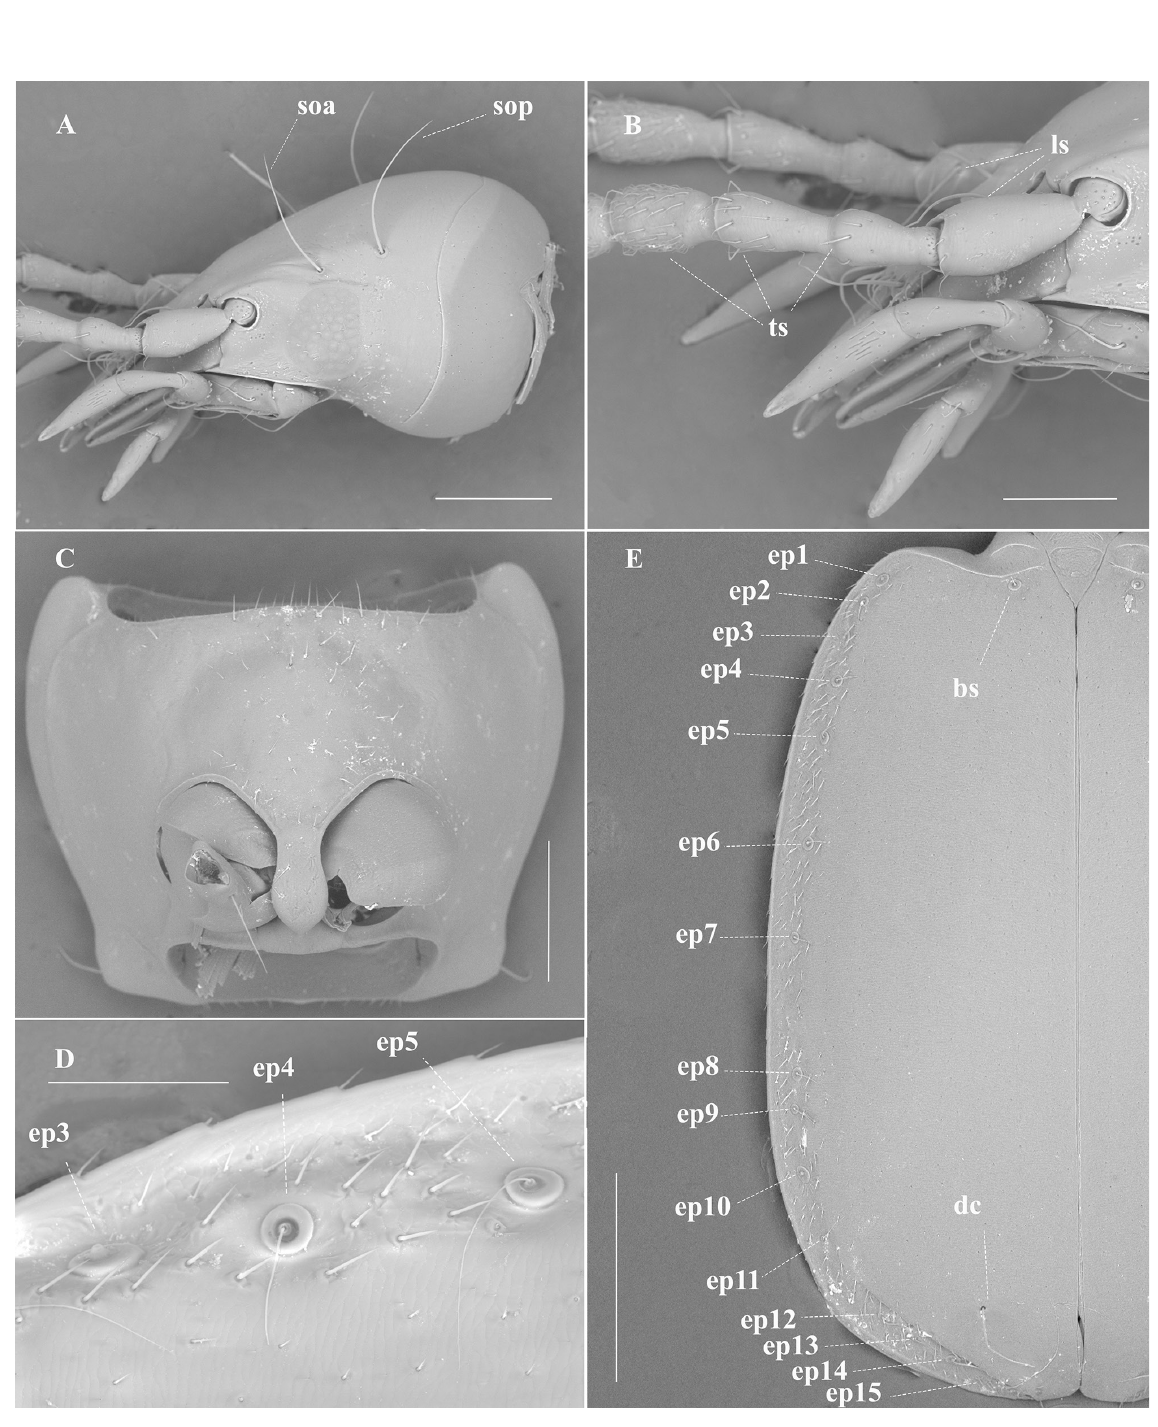
Fig. 2. Perigona ( Neoperigona ) spelunca sp. nov. (ISLA 66142). A . Head, lateral view. B . Antennae, detail. C . Prosternum. D . Elytral pores 3–5, detail. E . Elytra, dorsal view. Abbreviations: bs = elytral basal/scutellar seta; dc = elytral aplical discal seta; ep1–15 = elytral pores of setae 1–15 from the umbilical series; ls = antennal scape long setae; soa = supraorbital setae anterior; sop = supraorbital setae posterior; ts = antennal trichoid sensilla. Scale bars: A, C = 250 μm; B = 150 μm; D = 100 μm; E = 500